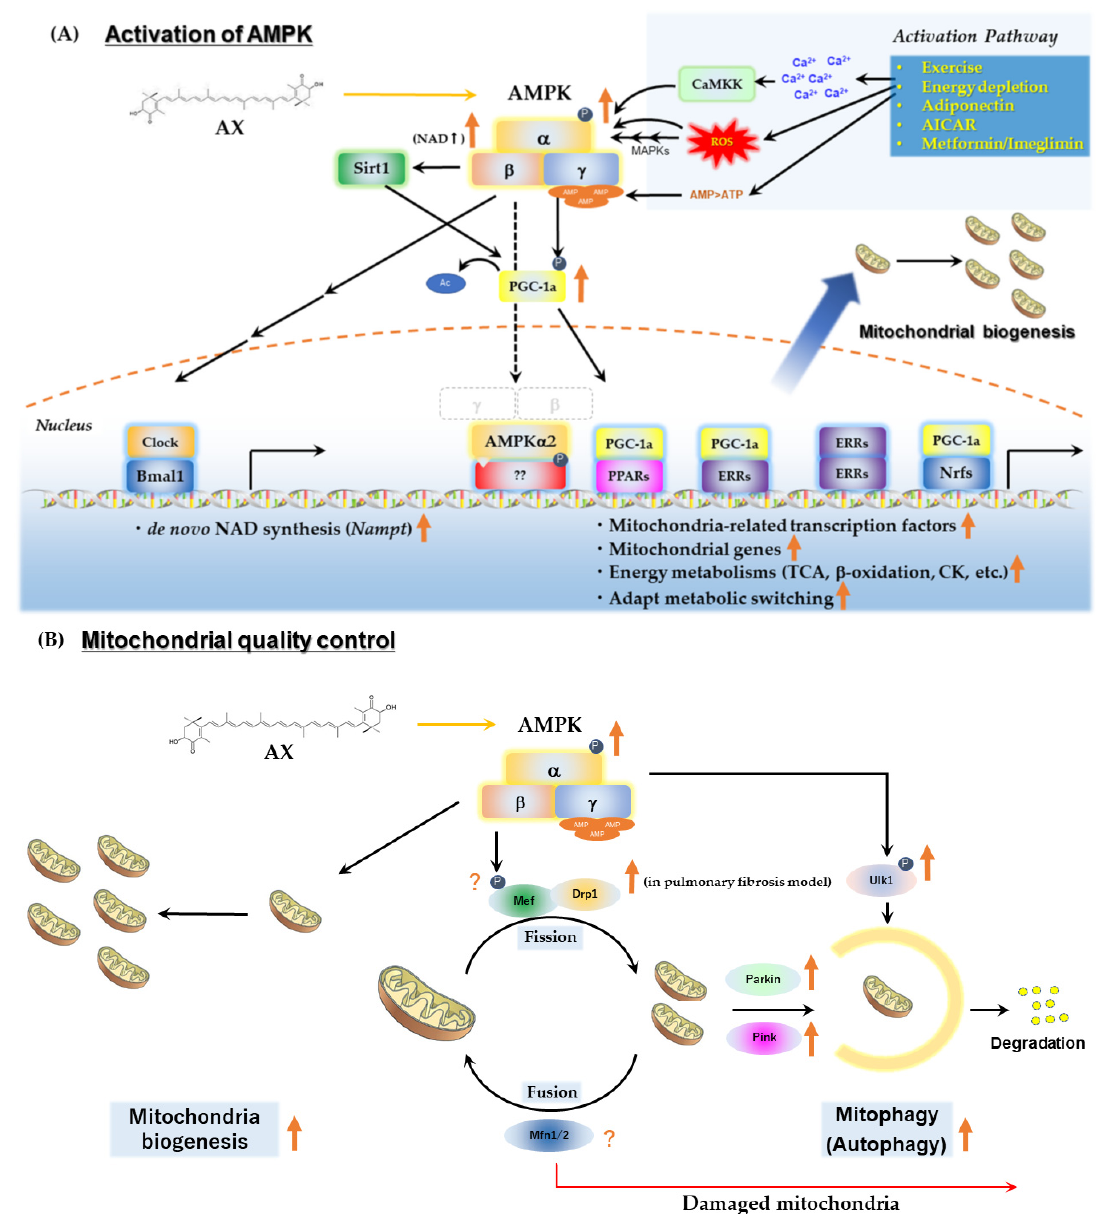
Figure 4. AX regulates various mitochondria-associated metabolic pathways, mitochondrial biogenesis and its quality control via AMPK activation. ( A ) AMPK is activated by exercise, energy depletion, or certain active drugs (e.g., AICAR, adiponectin, metformin and imeglimin) by (1) increased Ca2+ influx; (2) direct modification by ROS and activation of MAPKs; and (3) increased AMP/ATP ratio. Activated AMPK induces activation of PGC-1 α and related gene expression, leading to enhanced energy metabolisms, adapted metabolic switching, and increased mitochondria biogenesis. Further- more, AMPK regulates gene expression of Nampt and promotes de novo synthesis of NAD+ in the cell. As a result, it enhances the activity of Sirtuins and further enhances the activity of PGC-1 α . Thus, AMPK/Sirtuins/PGC-1 α forms a pos- itive feedback loop in their actions. ( B ) AMPK contributes to mitochondrial quality control; AMPK not only enhances mitochondrial biogenesis, but also regulates mitochondrial fission and fusion via phosphorylation of Mef, and induces mitophagy in autophagosomes via the phosphorylation of Ulk-1 for the impaired mitochondria. AX activates AMPK. In particular, it has been reported that AX affects the points indicated by the orange arrows. In this figure, precise and de- tailed signal pathways are not shown, to avoid complications. This figure was adapted from the reference [116,133,134].